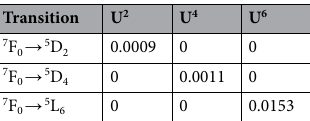
Table 1. RMEs of various transitions relevant for the JO parametrisation of the Eu 3+ excitation